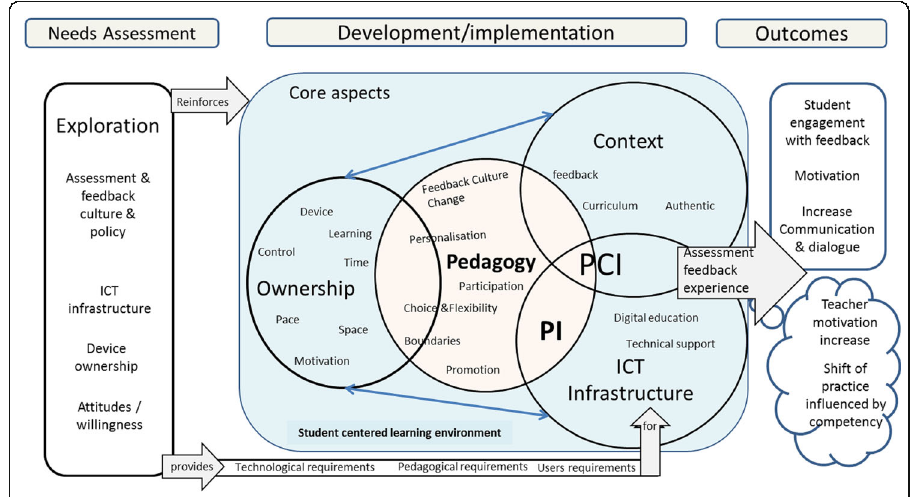
Fig. 5 Mobile Learning Framework for Assessment